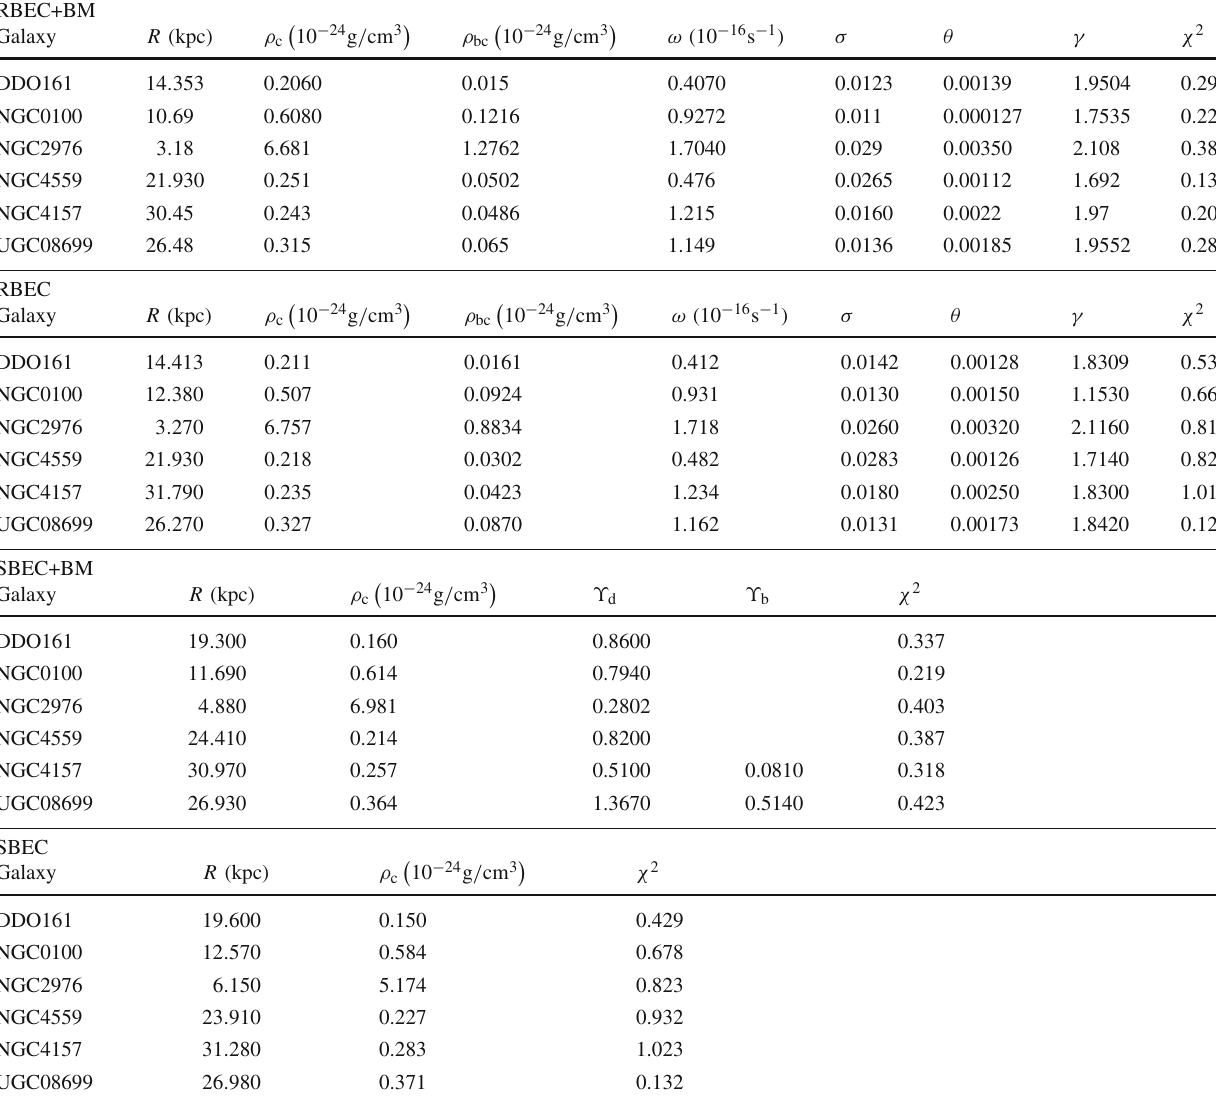
Table 5 Fitting results of the SBEC, SBEC+BM, RBEC, and RBEC+BM models with the SPARC observational